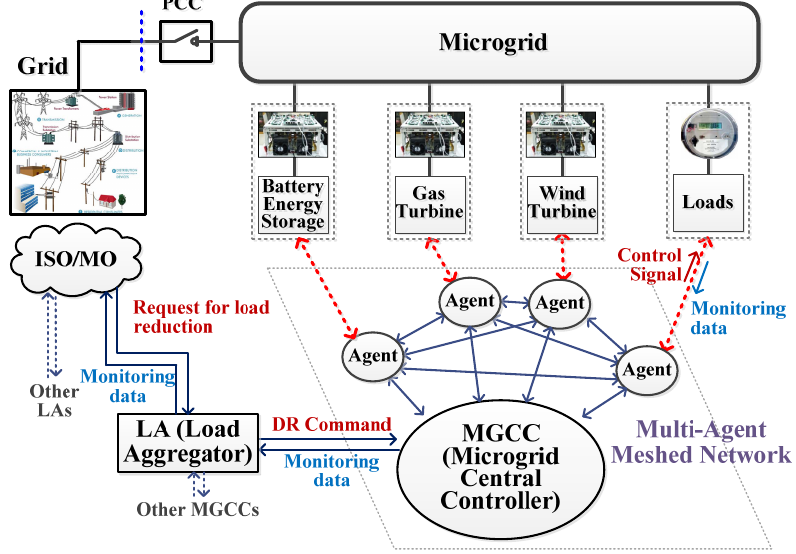
Figure 7. Configuration of multi-agent based microgrid energy management.